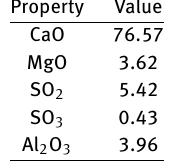
Figure 1: Graphical abstract